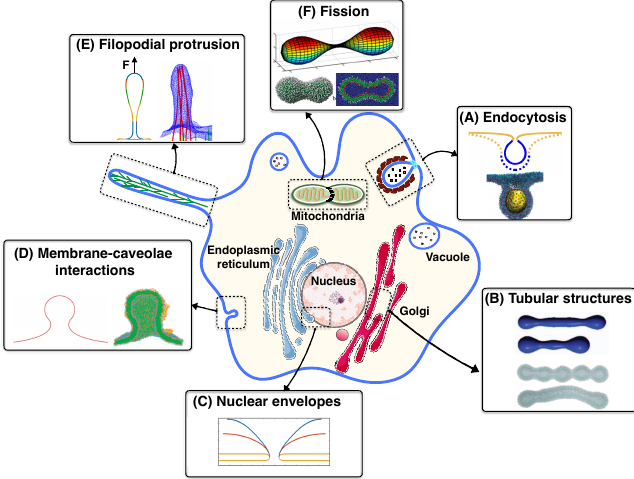
Figure 1. Membrane curvature generation in cells and associated modeling results: ( A )